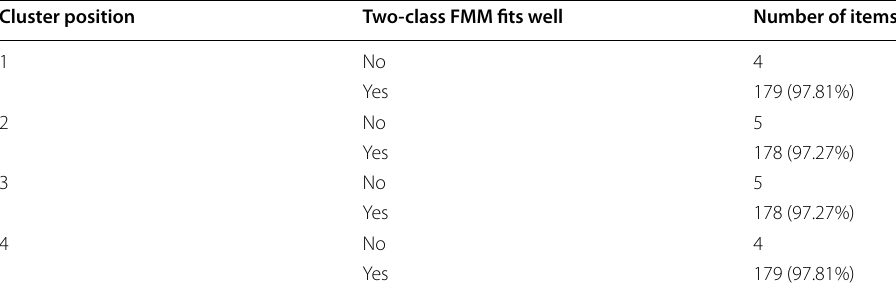
Table 2 Number of items according to the fit of the two-class FMM to the item RT data, by cluster position Cluster position Two‑class FMM fits well Number of